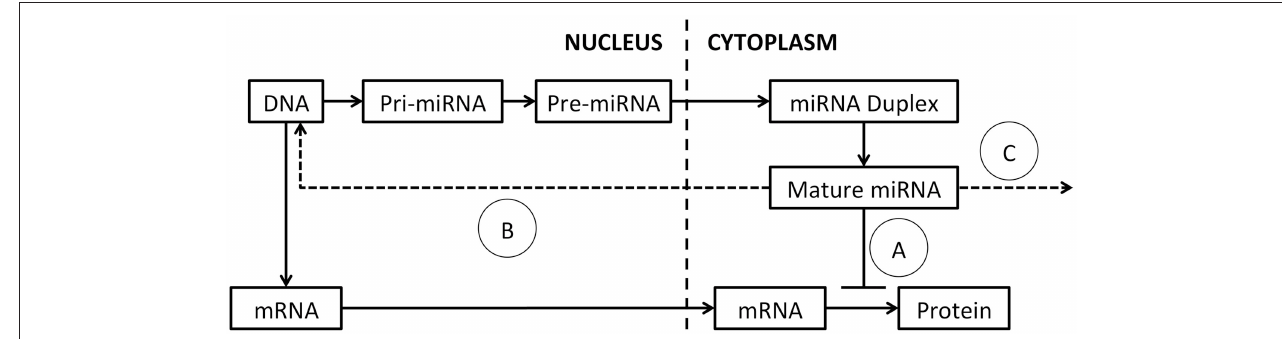
FIGURE 1 | MiRNA processing and function. The primary miRNA transcript (pri-miRNA) is transcribed from DNA and excised by Drosha, to produce the pre-miRNA. The pre-miRNA is exported to the cytoplasm by exportin-5 and spliced by Dicer to generate a miRNA duplex. The duplex is unwound by helicases and a mature single-stranded miRNA is assembled into the RISC complex. (A) MiRNA typically modulate target mRNA translation by complementary binding, within the 3 ′ UTR, 5 ′ UTR or coding region. New evidence suggests that miRNAs also function by (B) binding of DNA promoters, acting as RNA decoys or through direct binding of target mRNAs. (C) Mature miRNAs can also be released in exosomes and act on distant